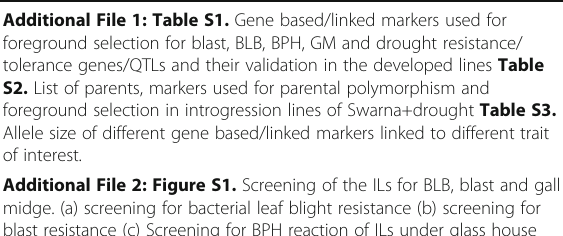
Additional File 1: Table S1. Gene based/linked markers used for foreground selection for blast, BLB, BPH, GM and drought resistance/ tolerance genes/QTLs and their validation in the developed lines Table S2. List of parents, markers used for parental polymorphism and foreground selection in introgression lines of Swarna+drought Table S3. Allele size of different gene based/linked markers linked to different trait of interest. Additional File 2: Figure S1. Screening of the ILs for BLB, blast and gall midge. (a) screening for bacterial leaf blight resistance (b) screening for blast resistance (c) Screening for BPH reaction of ILs under glass house condition (d) BPH screening of ILs under hotspot